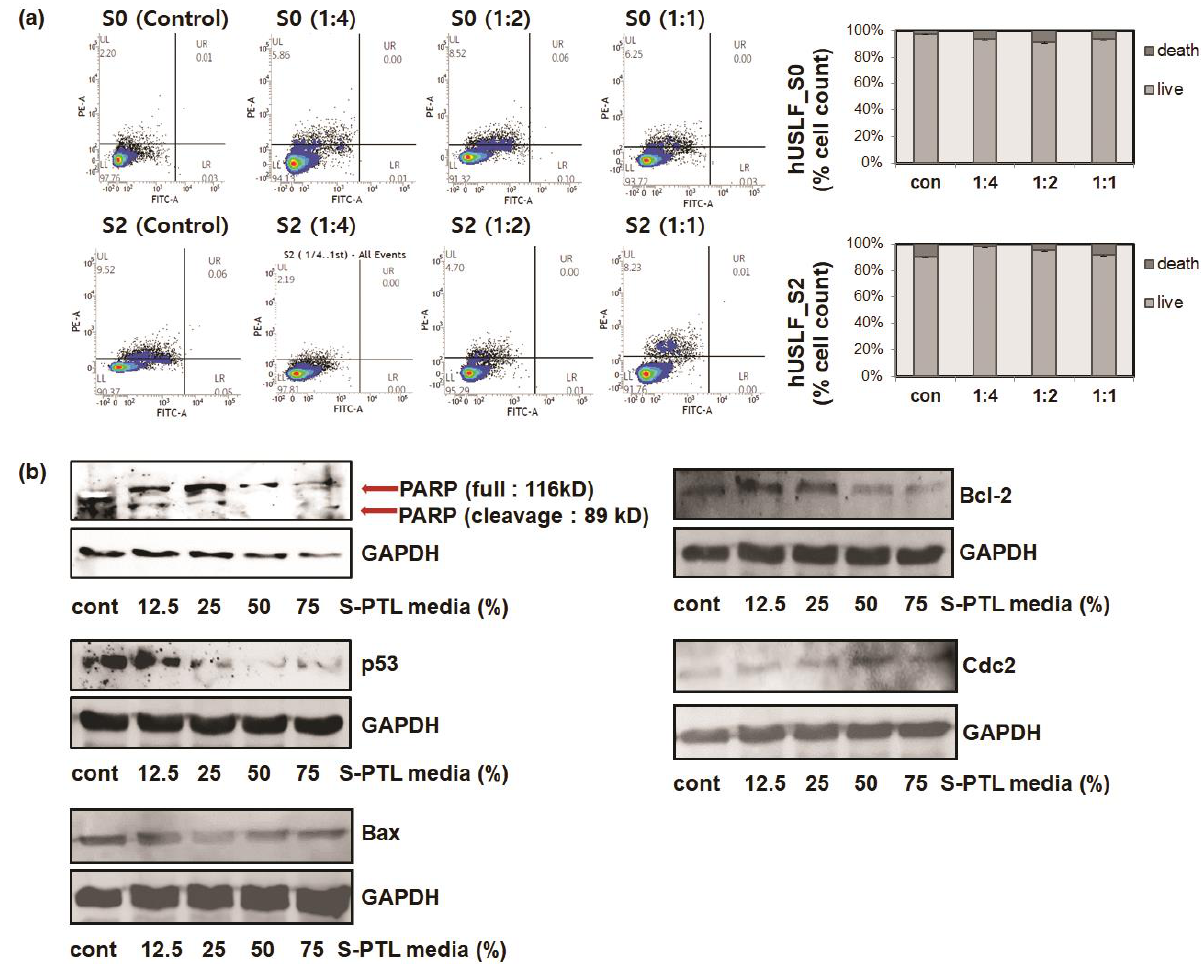
Figure 4. Apoptosis assay observed by Annexin V/propidium iodide (PI) staining and detected by flow cytometry ( a ). Recombinant Annexin V conjugated to fluorescein, the red-fluorescent PI nucleic acid binding dye. Platelet-treated liquid (PTL) treatment decreased human uterosacral ligament fibroblast (hUSLF) apoptosis at various dilution ratios. The hUSLF were exposed to 1:4 to 1:1 dilutions of PTL and cell culture medium. ( b ) The PARP and p53 expressions of hUSLF cells were inhibited by PTL treatment. Substrate cleavage by active PARP, Bax, Bcl-2, and Cdc2 was analyzed by immunoblotting with 1:8, 1:4, 1:2, and 1:1.3 ratios of PTL:cell culture